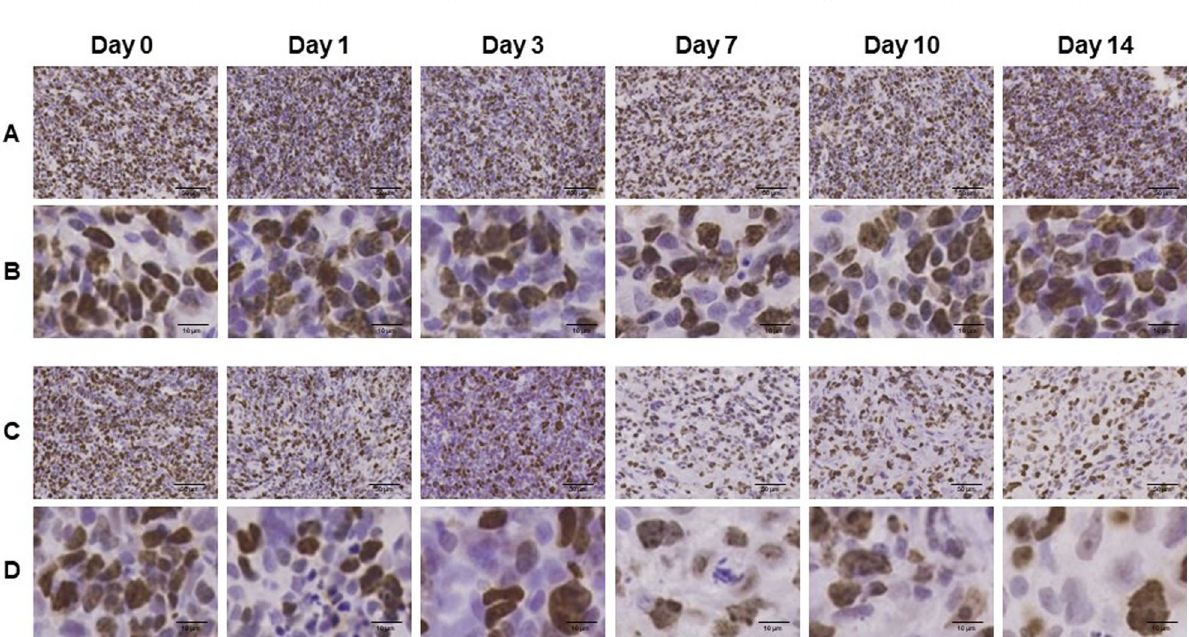
Figure 3. Ki-67 immunohistochemically stained sections of LNZ308 tumors after irradiation. The cell proliferation antigen Ki-67 was used as a marker of cell proliferation. Tumors on right paws were irradiated on day 0 at the dose of 0 Gy ( A and B ) or 60 Gy ( C and D ). Photomicrographs of low ( A and C ) and high ( B and D ) magnification. Ki-67 stained tumor sections are shown at days 0, 1, 3, 7, 10, and 14 after irradiation (N = 1 each treatment